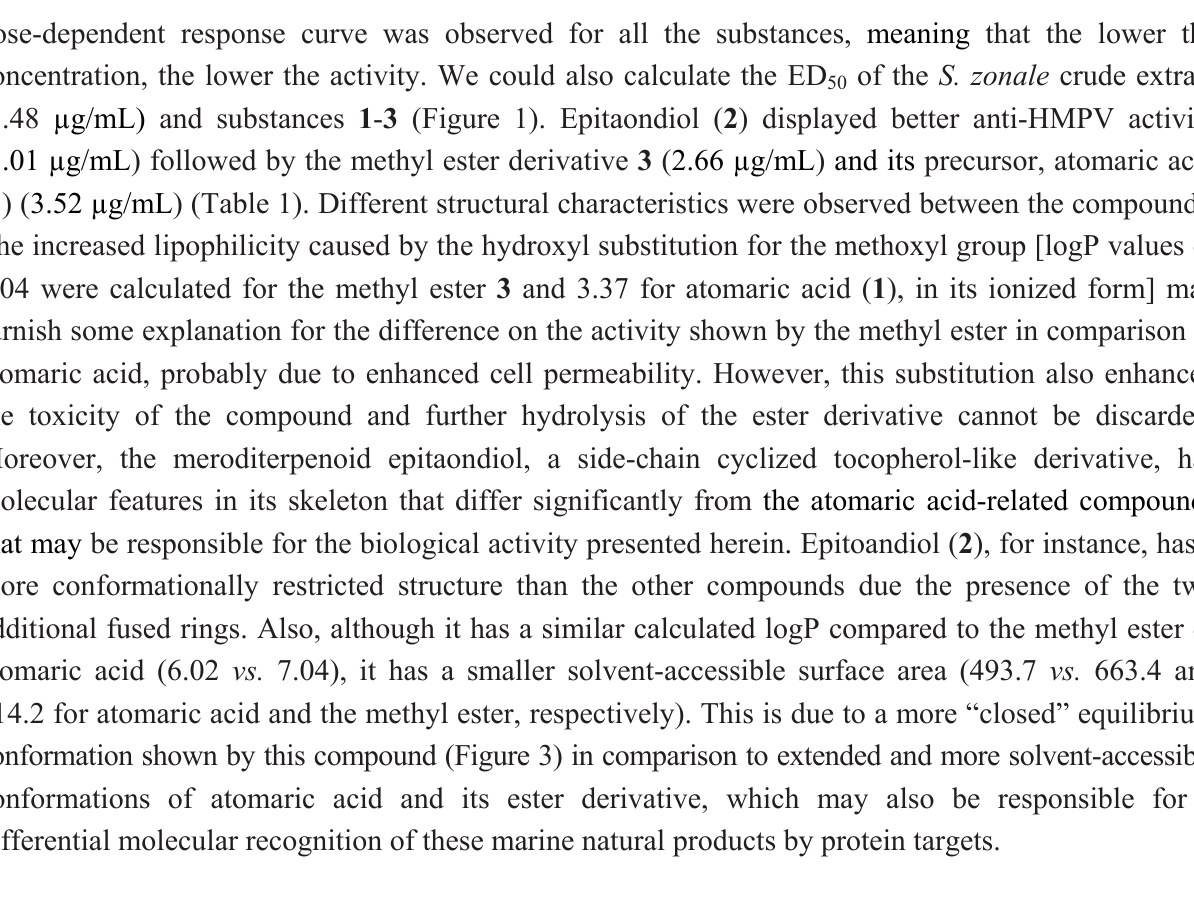
Figure 3. Energy-minimized 3D structures of atomaric acid ( 1 ), epitaondiol ( 2 ) and atomaric acid methyl ester ( 3